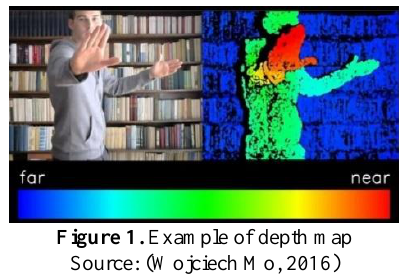
Figure 1. Example of depth map Source: (Wojciech Mo,